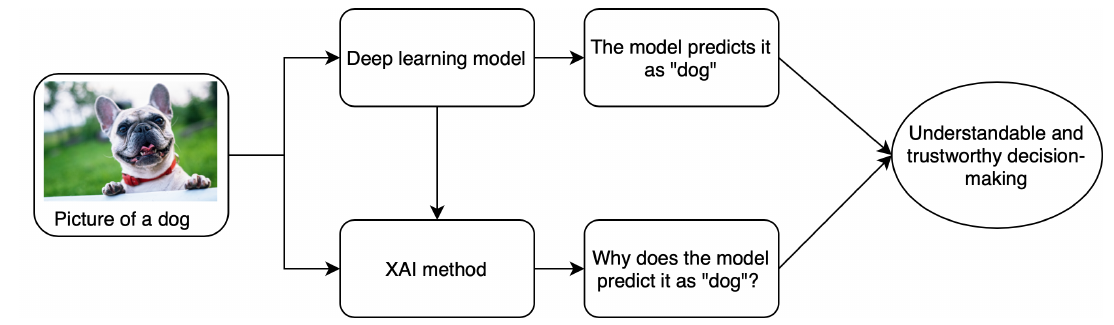
Figure 1. A brief schematic of basics of XAI